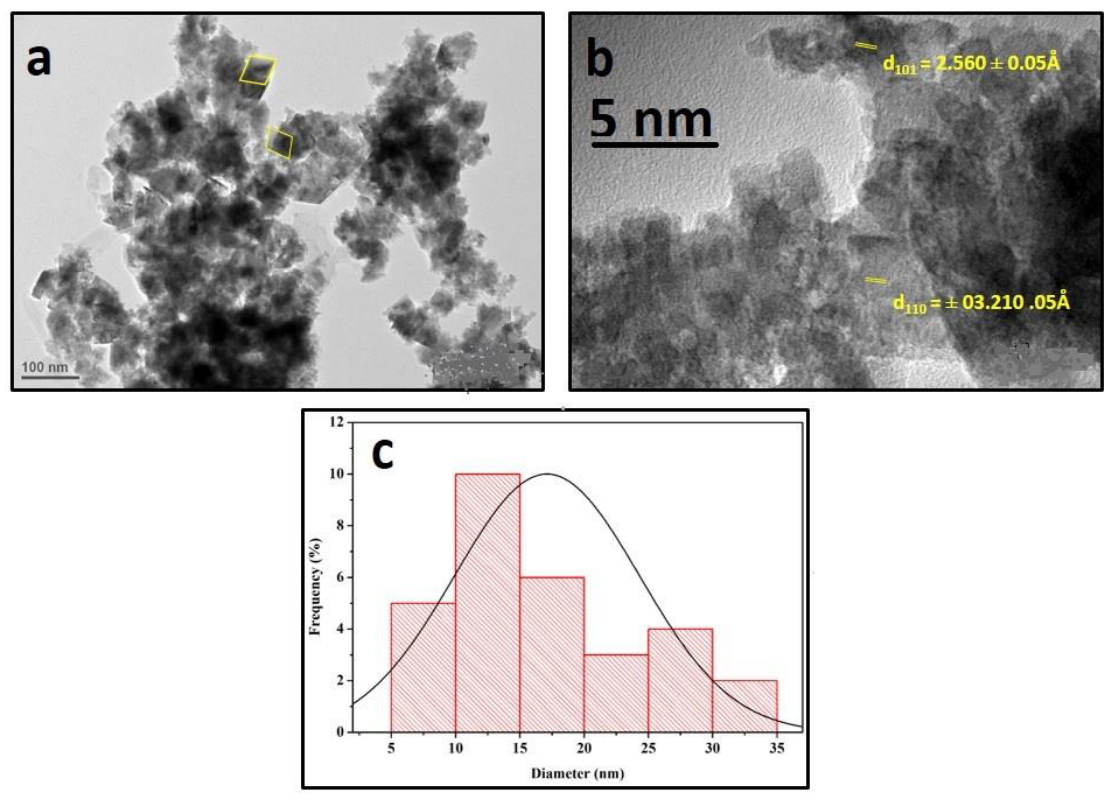
Figure 2. ( a ) TEM micrograph, ( b ) HR-TEM image and ( c ) size distribution histogram of Ruthenium oxide nanoparticles.